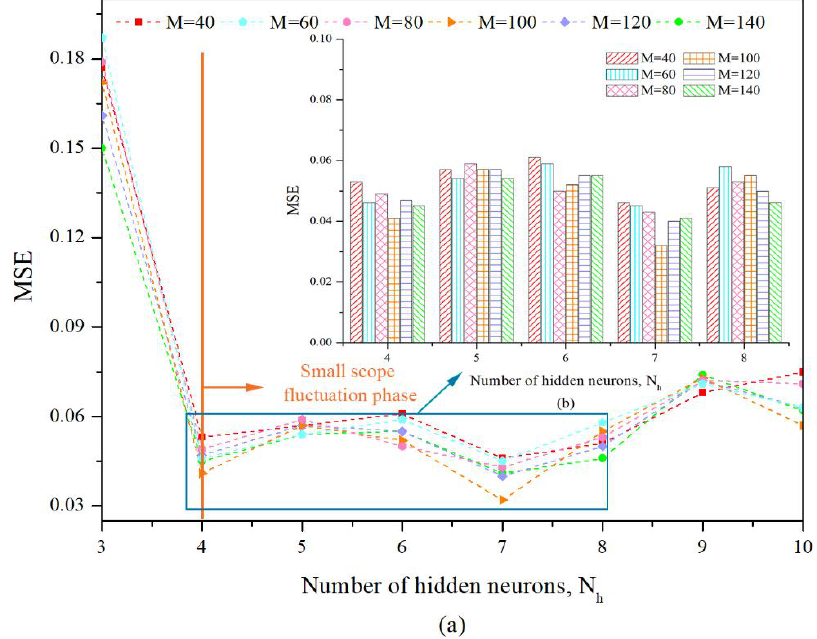
Figure 4. Performance of IABC-BP models with various parameter settings: ( a ) MSE distribution at the entire range (3–10) of 𝑁 ℎ ; ( b ) MSE distribution at the selected range (4–8) of 𝑁 ℎ